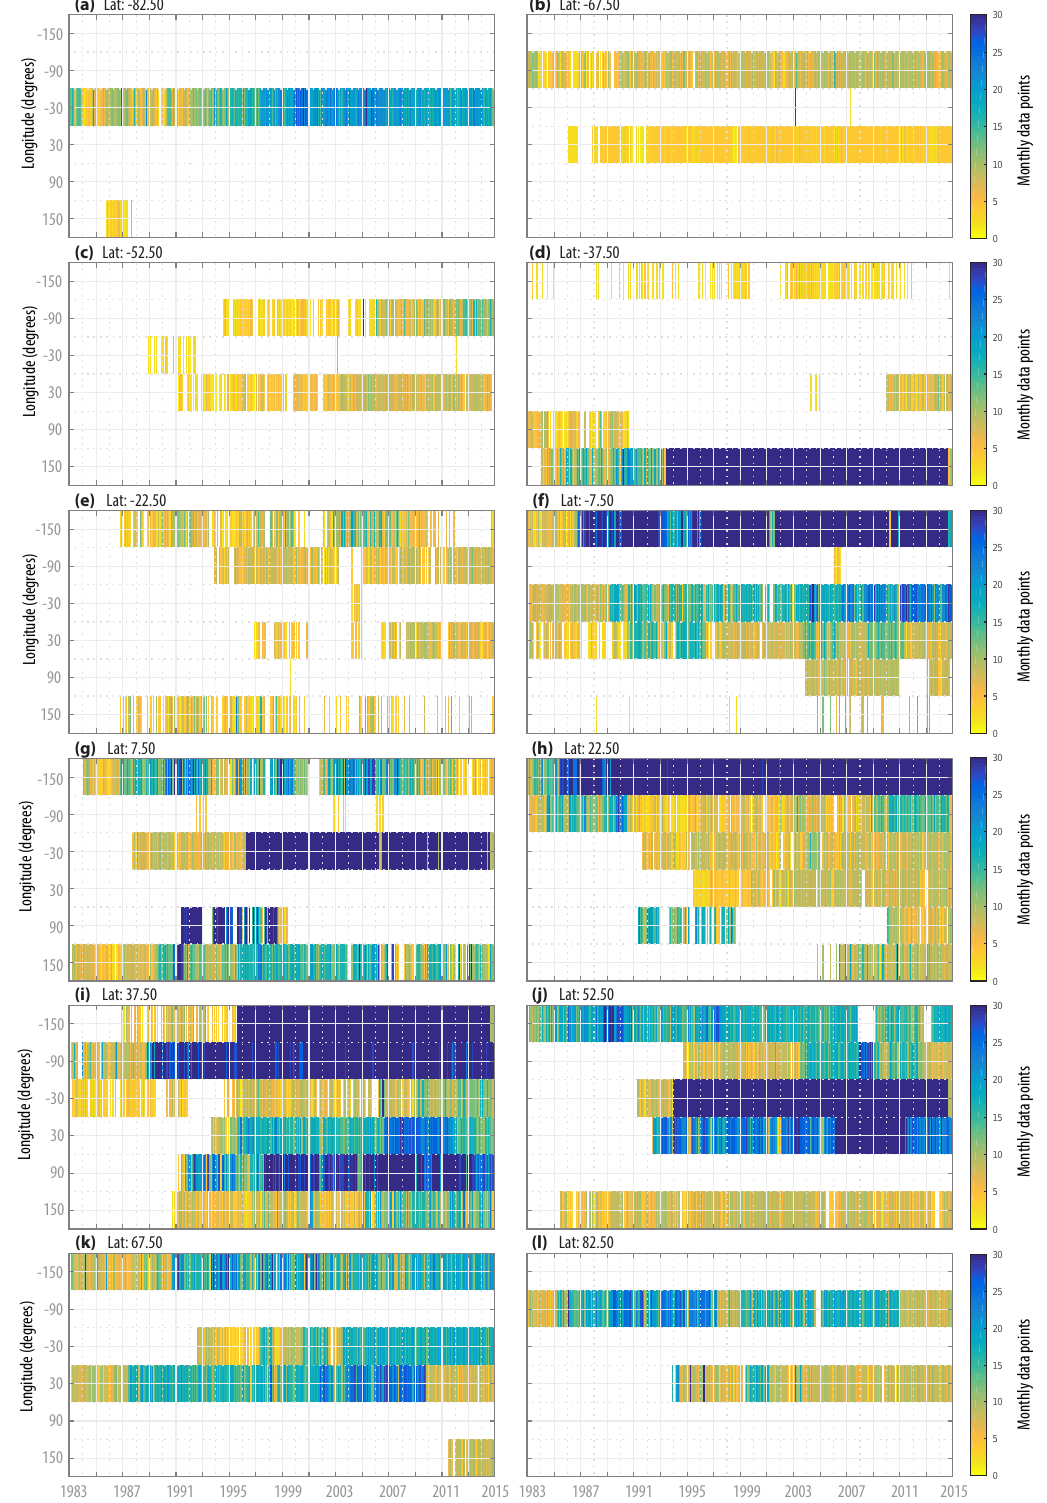
Figure 3. Availability of instrumental CH 4 data from 1983 to 2015 from the AGAGE and NOAA ESRL networks, shown as data samples per month, per latitudinal band (a–l) and per longitudinal bin within each latitudinal